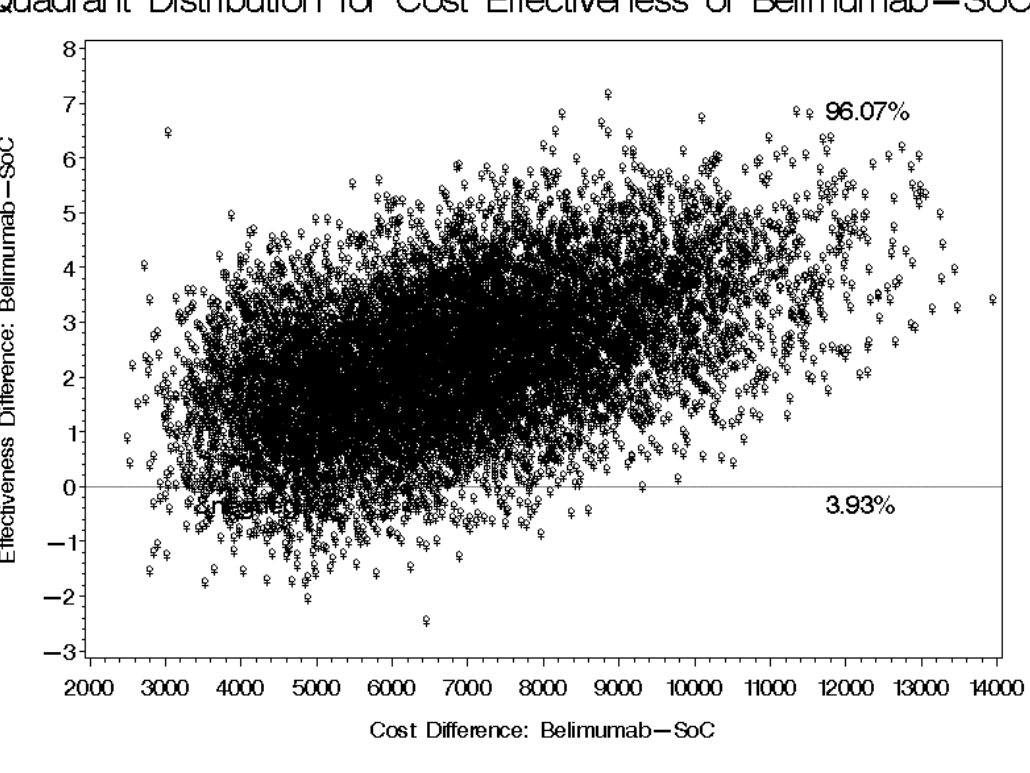
Figure 2. Bootstrap distribution of cost-effectiveness for the belimumab-based treatment regimen versus the standard of care (SoC) for patients at the annual screening.